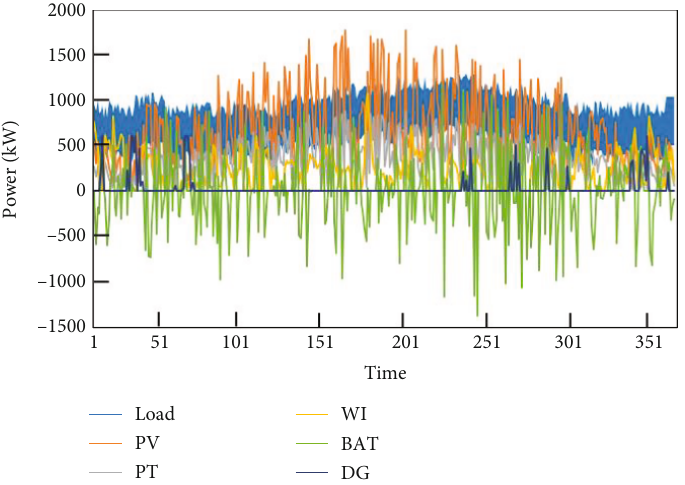
Figure 10: Annual distributed power output and load of microgrid.